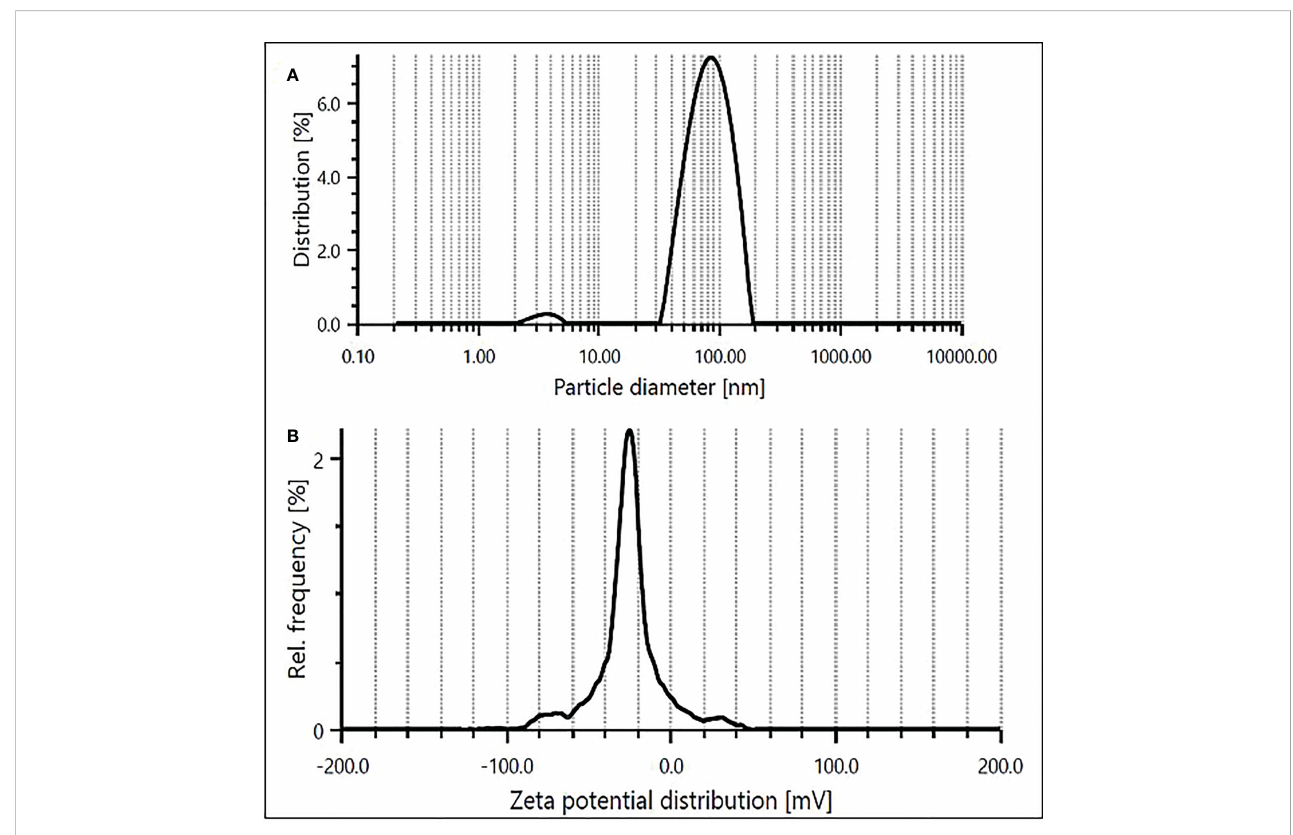
FIGURE 4 Size distribution (A) and zeta potential (B) of ZnO NPs obtained using aqueous extracts of pecan leaves.